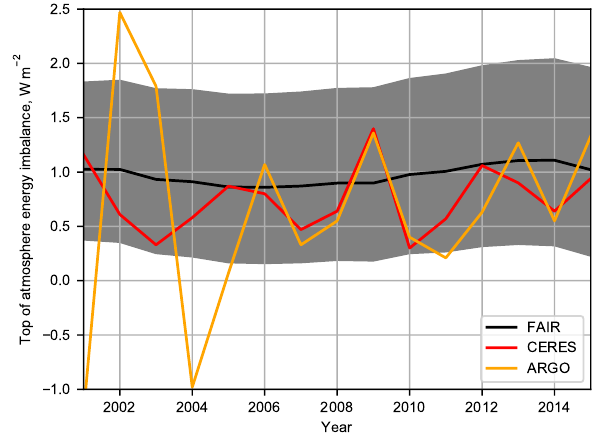
Figure 9. Transient climate response to CO 2 emissions (TCRE) for FAIR based on RCP8.5 for all forcing (red) and for CO 2 -only forc- ing (black).